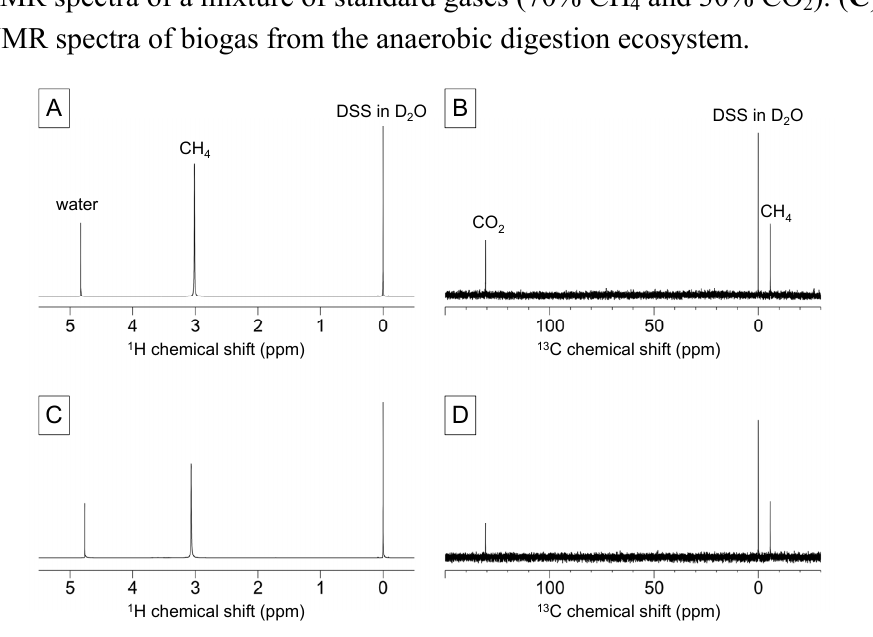
and 30% CO ). ( C ) 1 H- and 4 2